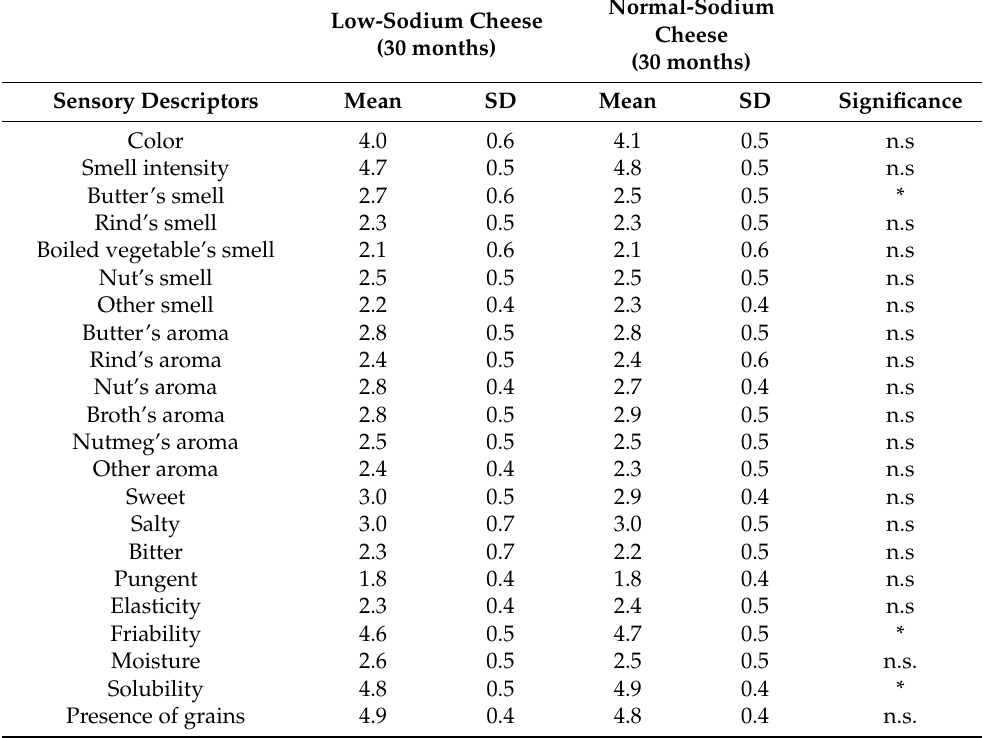
Table 6. Descriptive statistics and t-test significance for 30-month-ripened